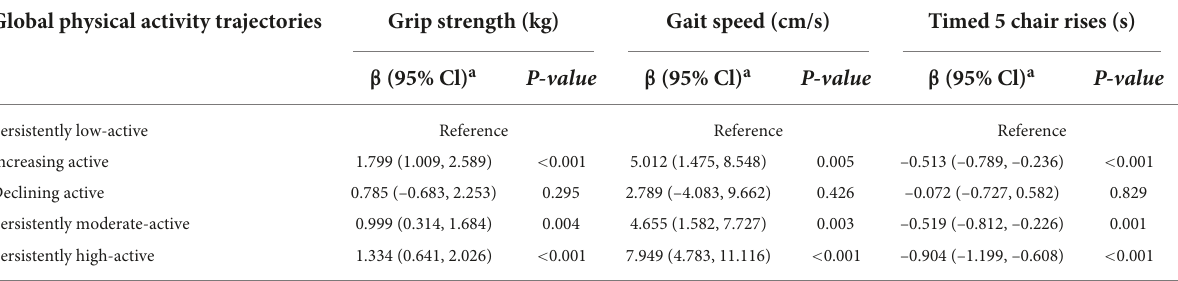
TABLE 2 Mean differences of changes in physical function between global physical activity trajectories.